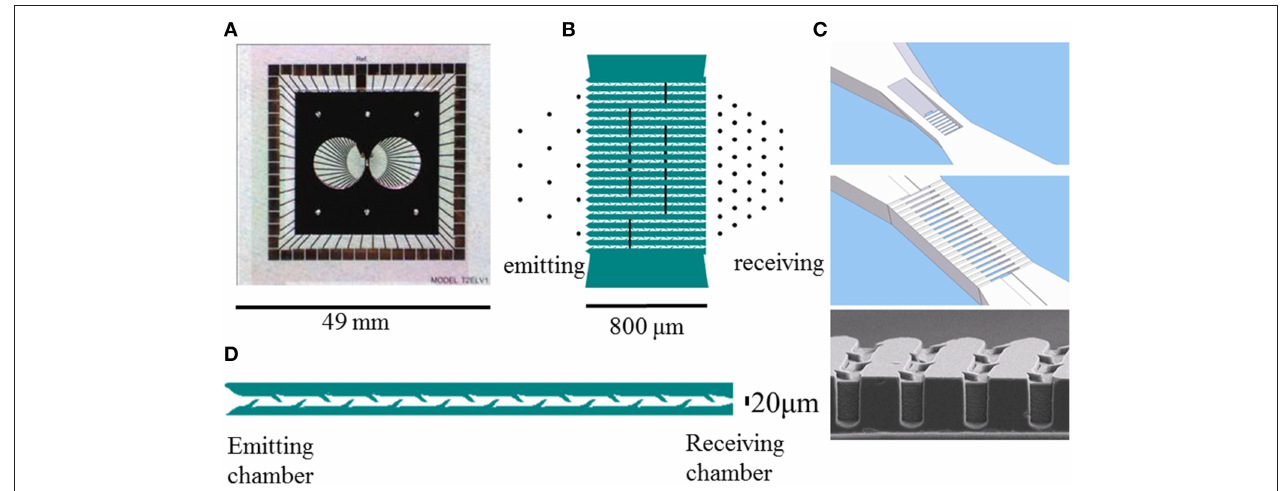
FIGURE 1 | Layout of the culturing chambers, channels, and electrodes of glass-silicon DCMEAs. (A) shows the complete DCMEA, (B) depicts the layout of electrodes (black lines and dots, Ø: 30 µ m) and channels (green). (C) shows a top and bottom view of the connecting channels. The barbed channels are 5 µ m high at the entrance and exit, and the central part of the channels has no ceiling to enable visual access. Total channel length: 800 µ m, channels, and walls running from lower left to upper right are indicated in (B) in white and green, respectively. Bottom image shows an electron microscopy image of the barbs in the channels. (D) Close-up of a channel (10 barbs per side, length:800 µ m, width: 20 µ m, all dimensions are to scale). Glass PDMS DCMEAs had a similar layout, but the channels were shorter (540 µ m, five barbs per side).